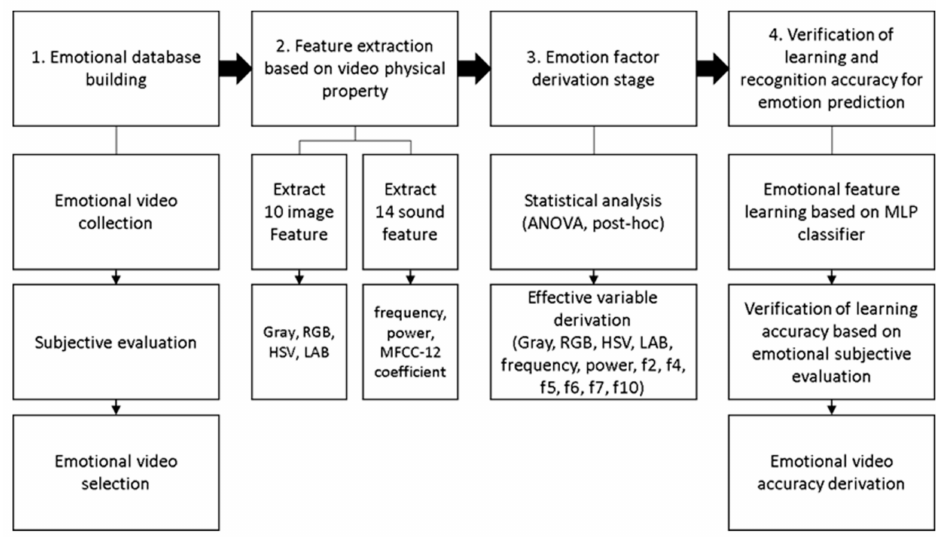
Figure 2. Data processing diagram. HSV: hue, saturation, value, LAB: light, the ratio of change from red to green, the ratio of change from blue to yellow, MFCC: Mel-frequency cepstral coe ffi cients, MLP: multilayer